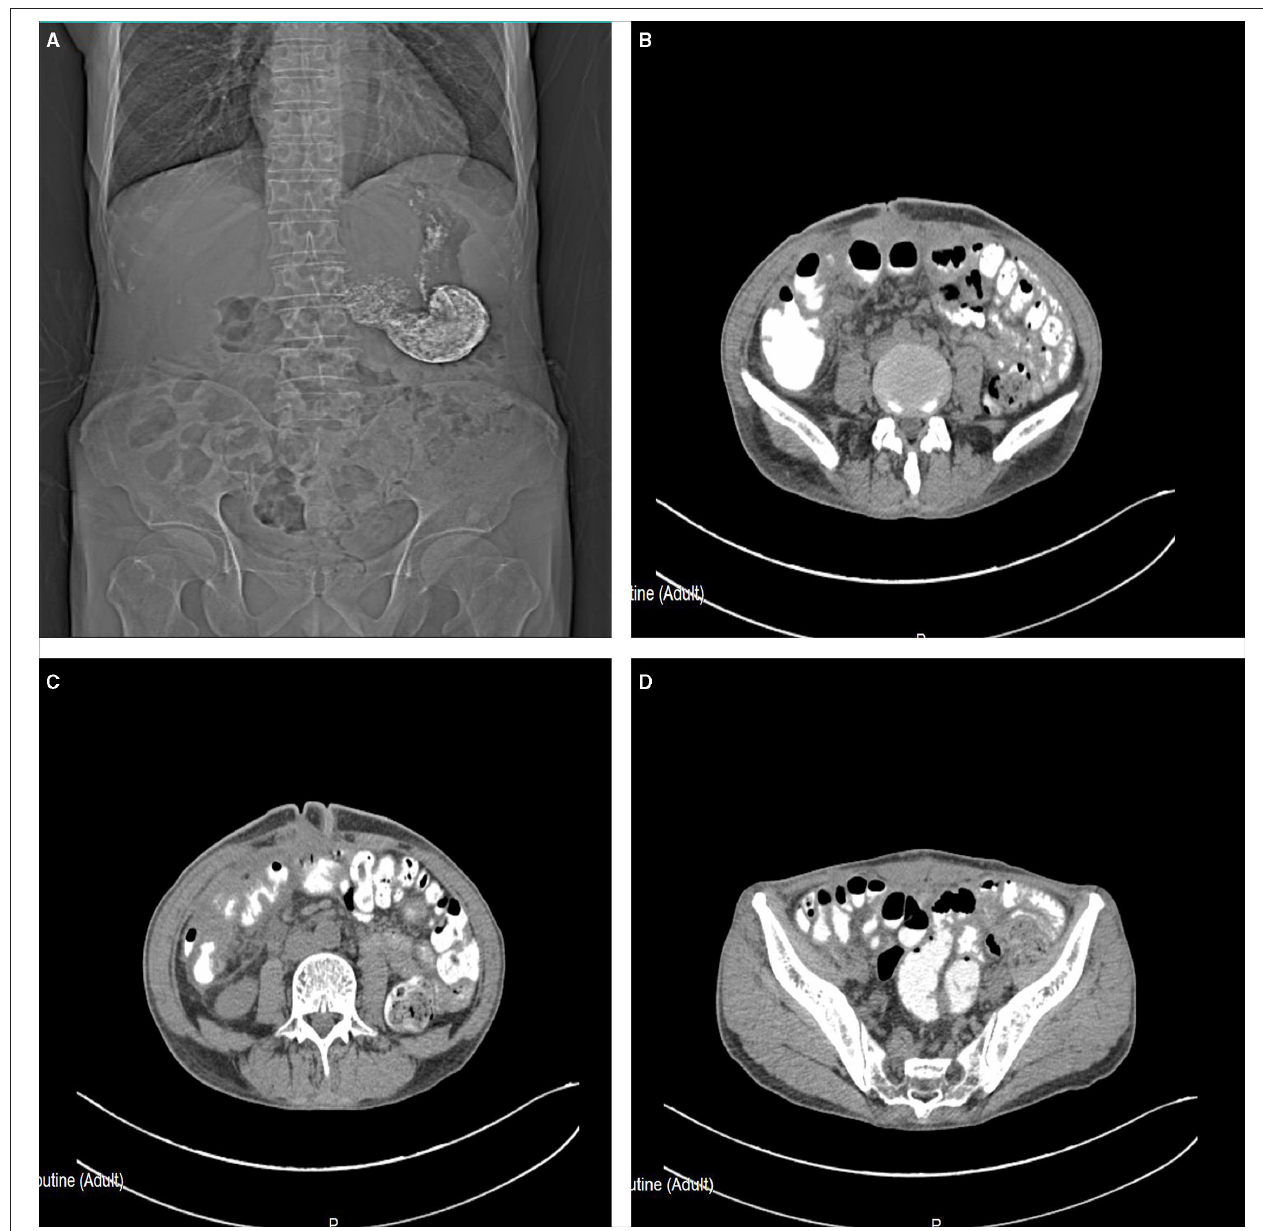
FIGURE 4 | On the seventh day postoperation, the gastrointestinal angiography (A–D) showed that there was no leakage of the contrast agent in the abdominal